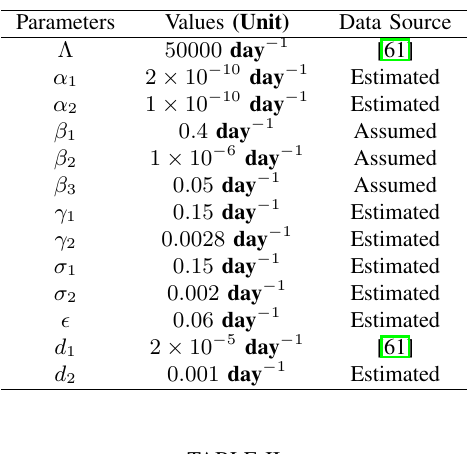
M ODEL PARAMETERS FOR C OVID -19 SYSTEM